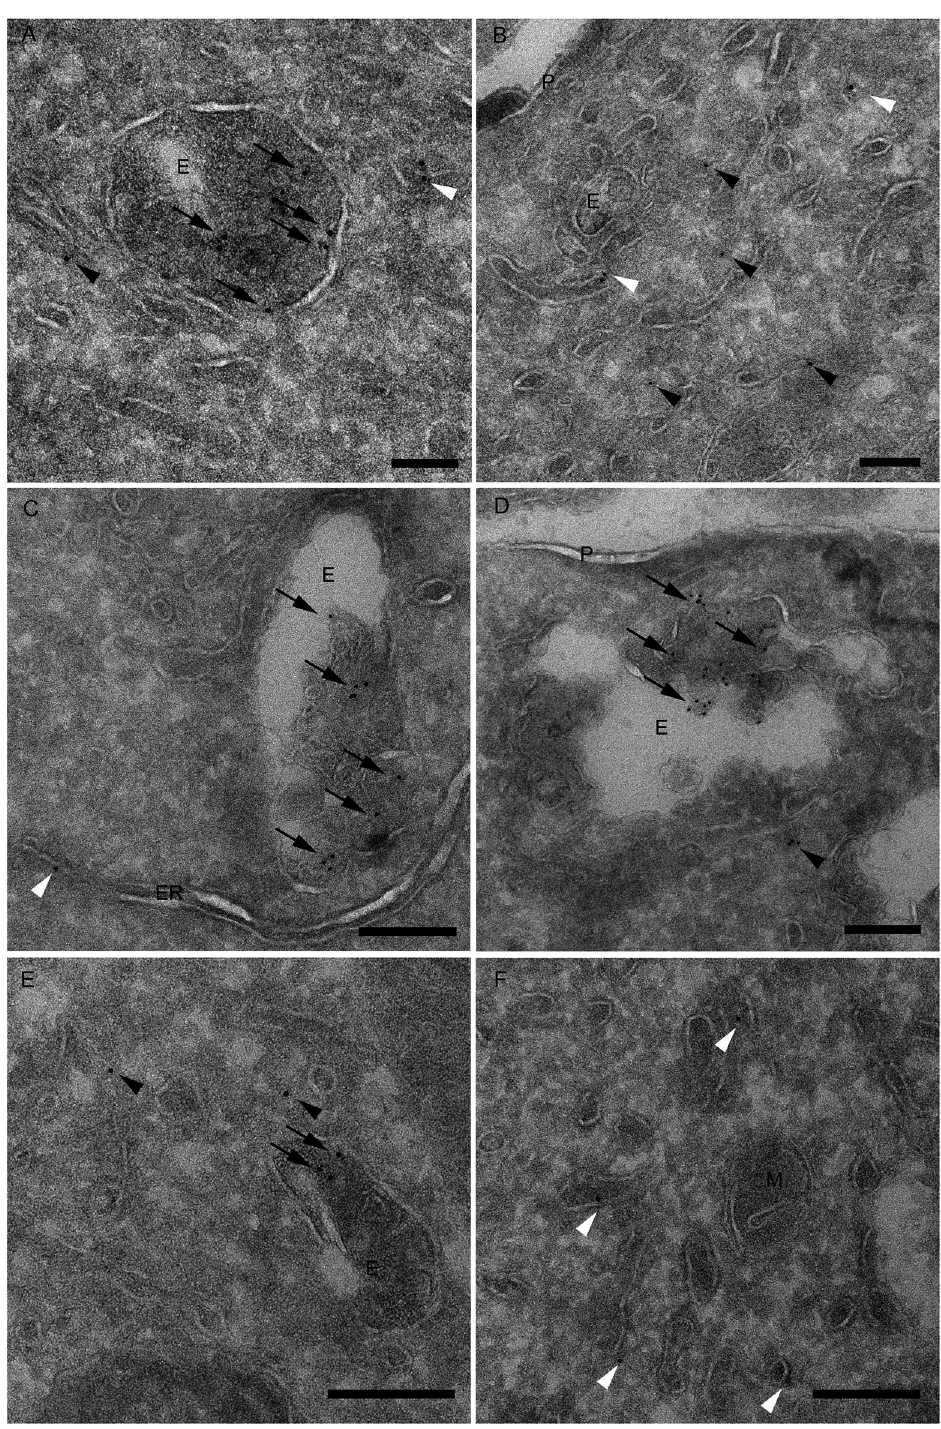
Fig 5. EM analysis of intracellular distribution of reovirus cores. WT, KO, and KO+ HBMECs were adsorbed with Alexa Fluor 647-labelled reovirus for 45 min, treated with cycloheximide, fixed 8 h post-adsorption, and prepared for immunolabeling of thawed cryosections using a rabbit core-specific antiserum and an anti-rabbit secondary antibody conjugated with 10 nm colloidal gold particles. (A, B) In WT cells, label is observed in endosomal vacuoles, which often contain internal membranes and amorphous, electron-dense material. Label outside endosomes is associated with membranes, including vesicles and tubular structures (white arrowheads) or free in the cytosol (black